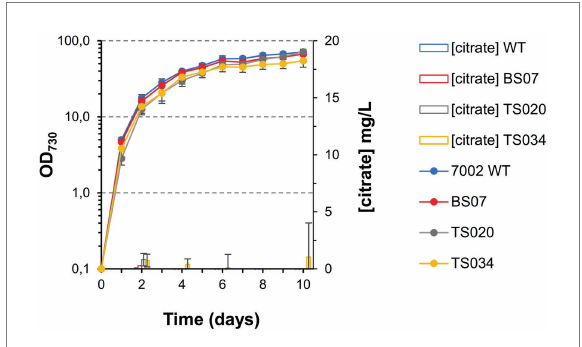
FIGURE 5 Growth curves and citrate quantification (in MAD, 1.5% CO 2 , high light) for background strains without acnB gene